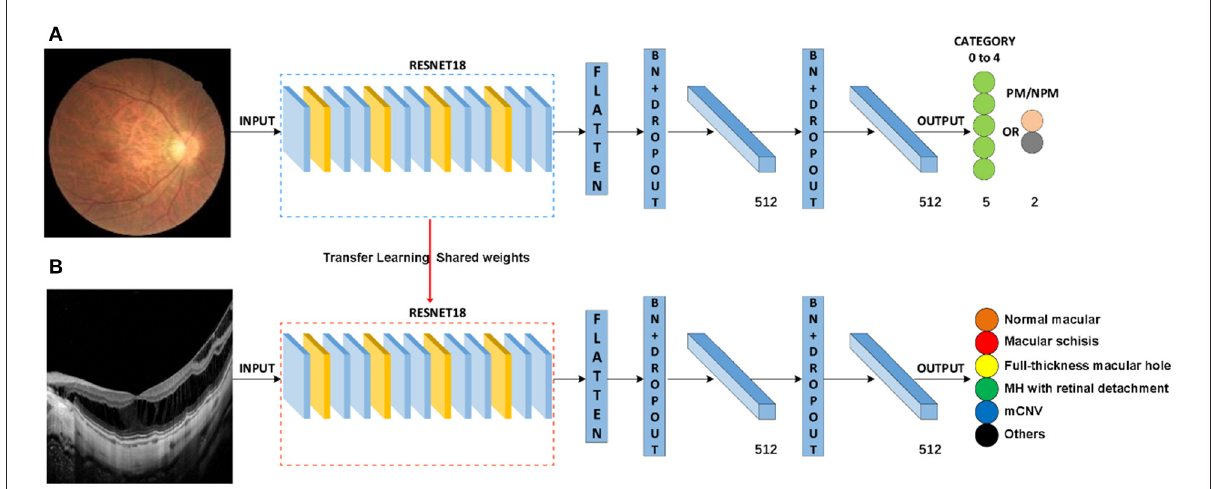
FIGURE3 Schematic diagram of algorithm architecture. (A) Architecture of classification algorithms in our previous study. (B) OCT image classification algorithm is constructed by the transfer learning